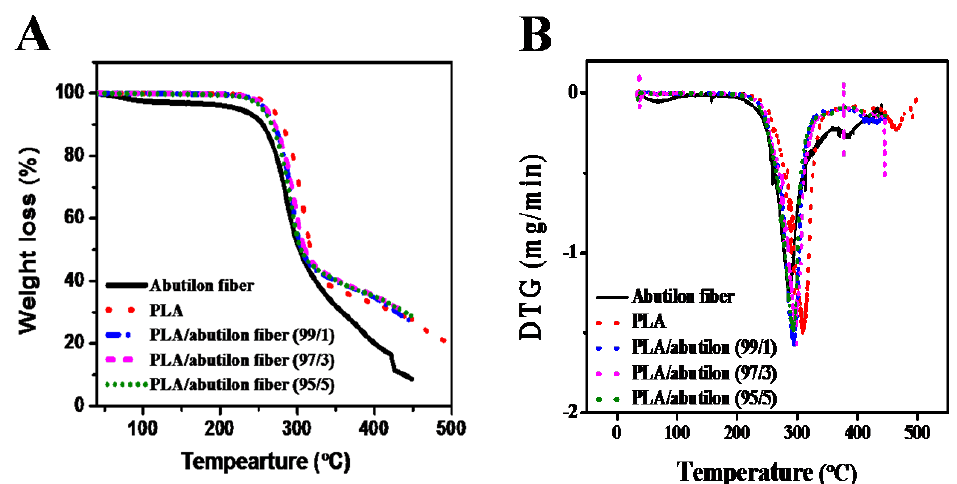
Figure 5. ( A ) TGA and di ff erential thermal gravimetry and ( B ) DTG of composite-reinforced abutilon fiber and PLA / abutilon fiber.